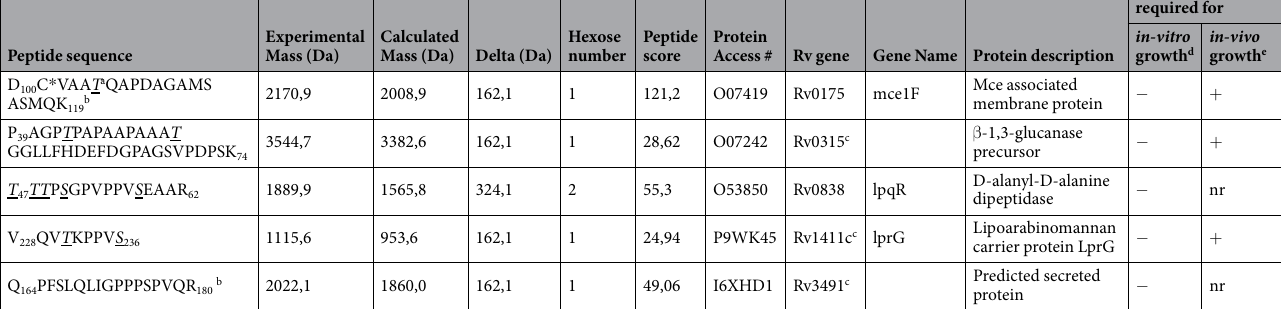
Table 1. Selected M . tuberculosis mannoproteins with high confidence glycopeptidomics identification. * Carbamidomethyl cysteine; a: Underlined italic characters figure the potential glycosylation sites predicted by Net-O-Glyc 3.1 server; b: also reported by Smith et al ., 2014; c: also detected by ref. 15; d: according 41, 42 ; e: according 43, 44 ; nr: not